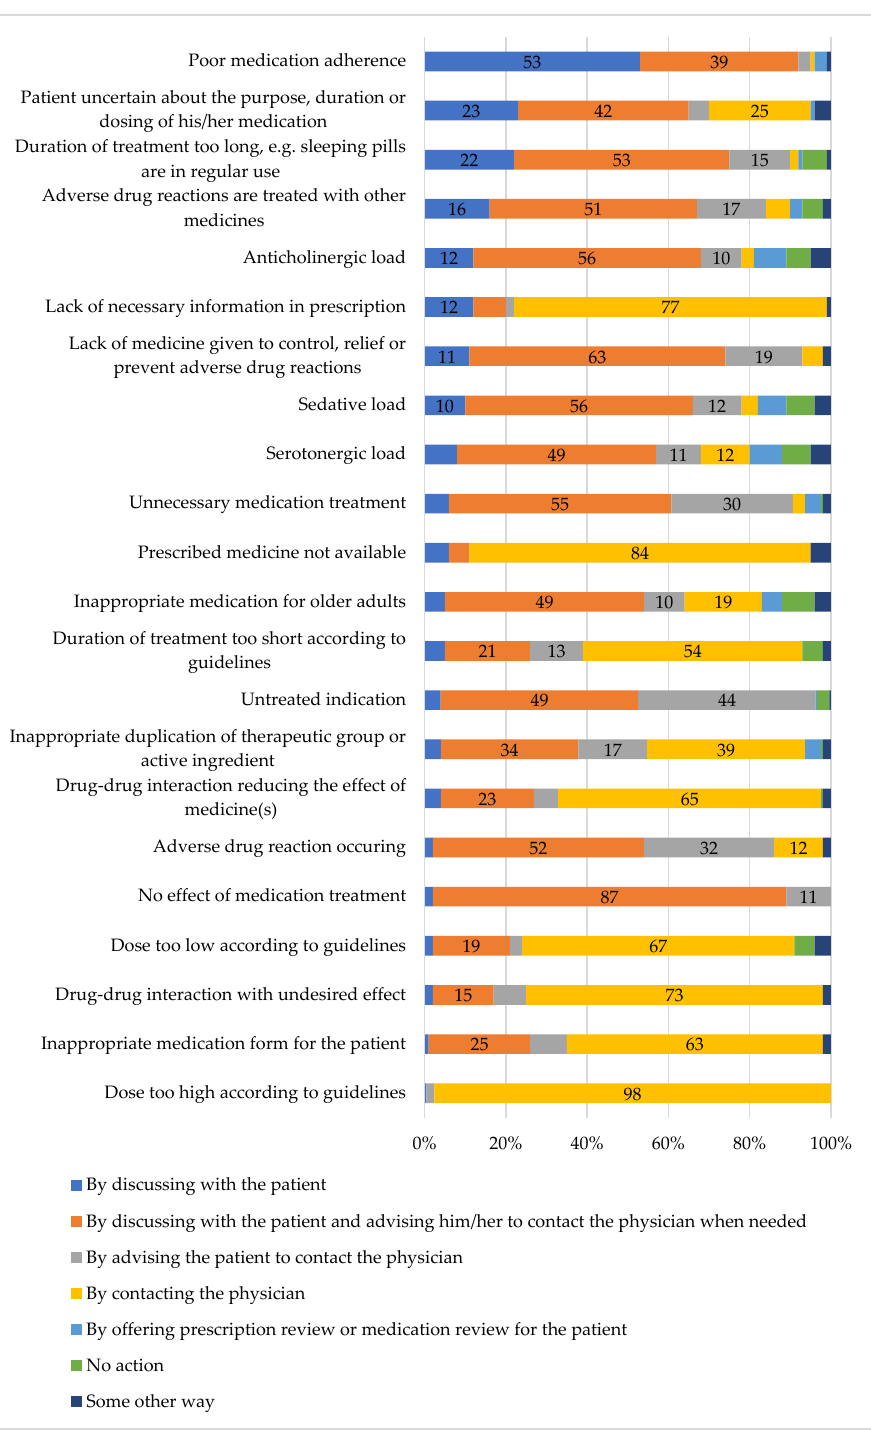
Figure 1. Strategies to solve medication-related risks during daily dispensing in community pharmacies (% of the responding pharmacies, n = 169. Responses that were given by less than ten per cent of respondents have not been